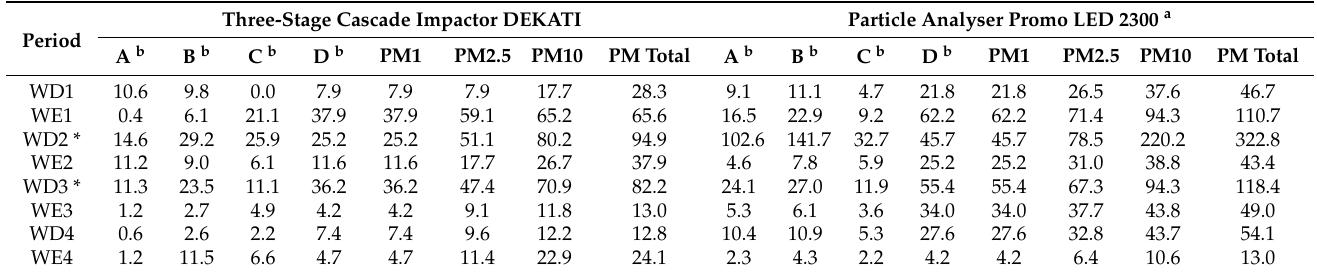
Table 2. Particle mass concentration in the different size ranges and PM values ( µ g/m 3 ).